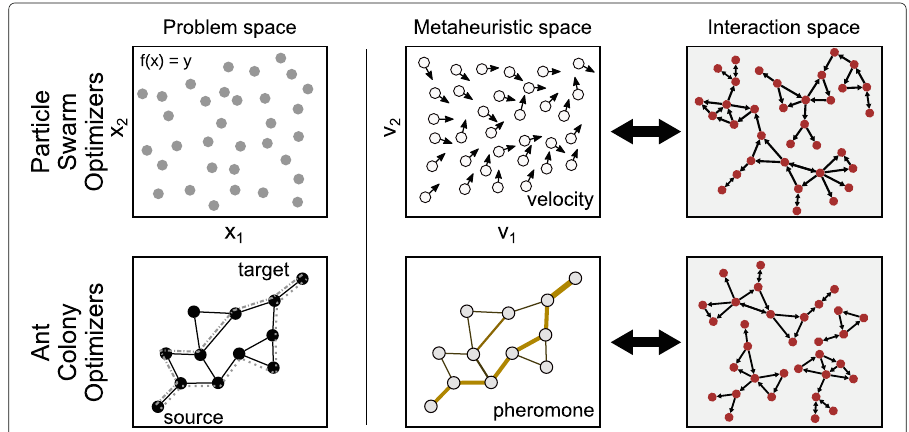
Fig. 3 Different viewpoints of swarm systems. We highlight that the interaction space is a general way of viewing these systems. Models of swarm intelligence are commonly used to solve continuous (top) and discrete (bottom) problems that can be represented in the problemspace (left). Each model incorporates metaphor-specific aspects such as velocities (first row) and pheromone (second row) in PSO and ACO, respectively, that can be represented in the metaheuristicspace (middle). However, regardless of the problem and the metaphor, the actions of individuals are interdependent and depend on the social interaction. The use of the interaction network allows us to represent the swarm social interaction in the interactionspace (right), enabling a unified assessment of